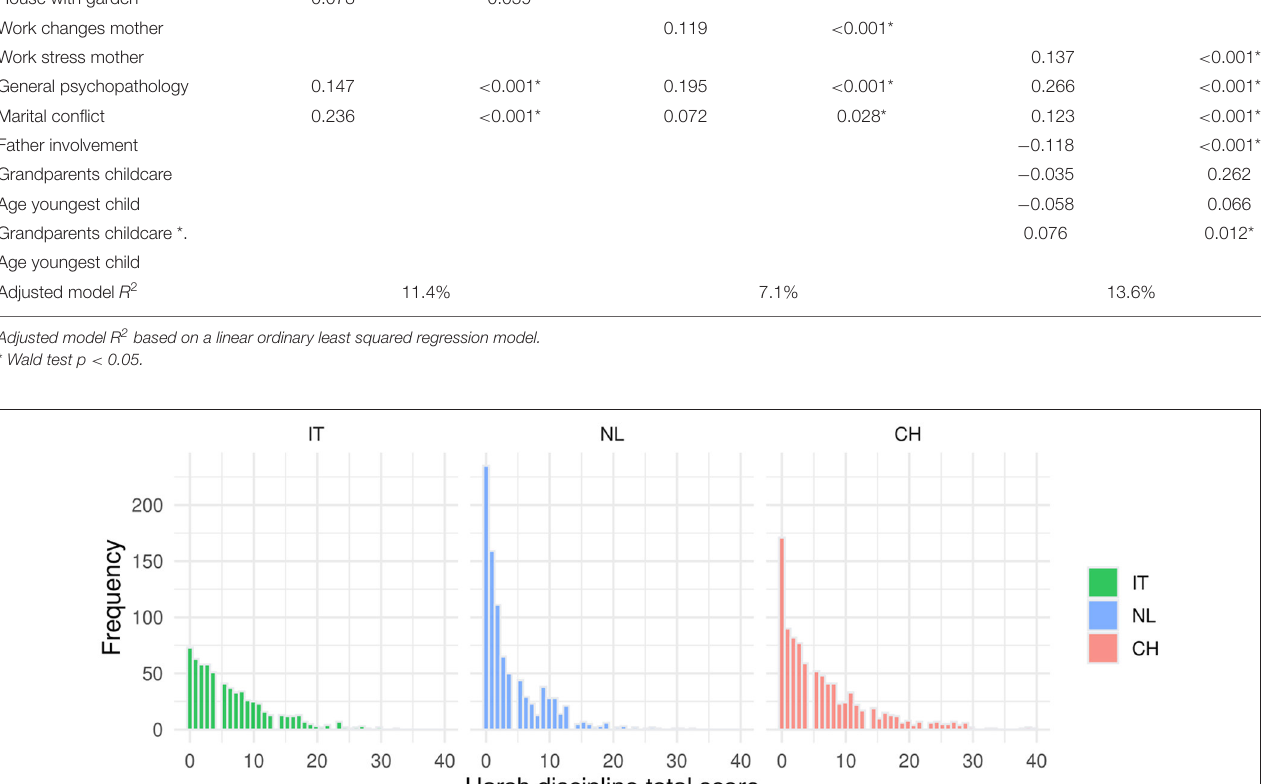
involvement of fathers, work-related distress, depression, anxiety, and posttraumatic stress disorder in the Dutch, Italian, and Chinese